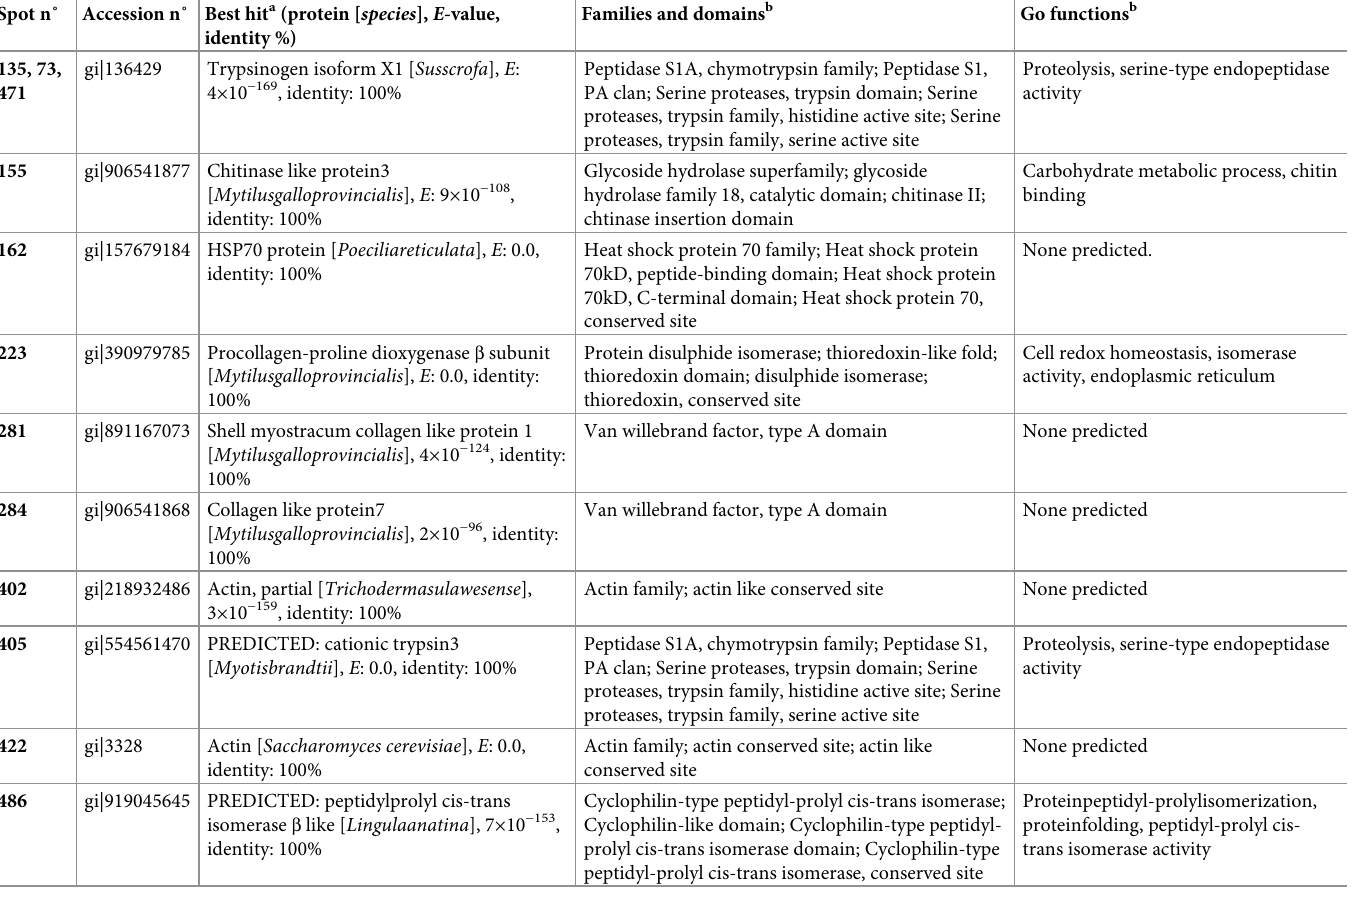
Table 3. Blast and interproscan search for hypothetical